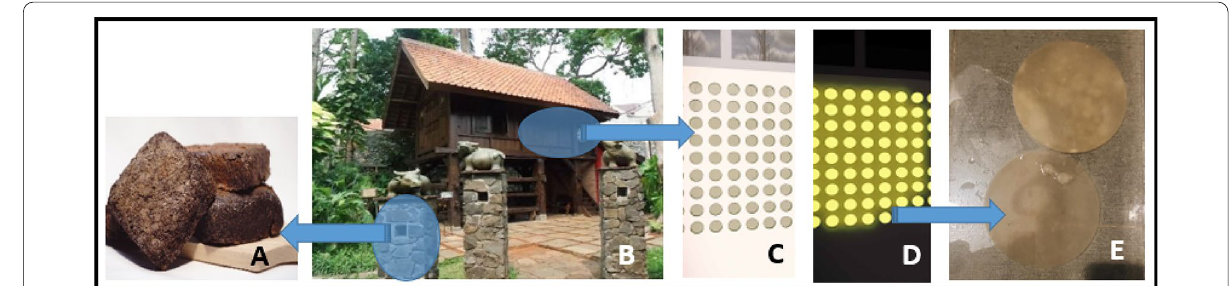
Fig. 7 Illustration of the use of Coffee Waste Materials ( A ) and Kombucha Tea ( E ); Eksterior view ( C ) and Interior view ( D ) of Kombucha Tea Applications. Source: Elaborated Photo ( B ) from Penerapan Arsitektur Neo–Vernakular pada Bangunan Fasilitas Budaya dan Hiburan (Widi and